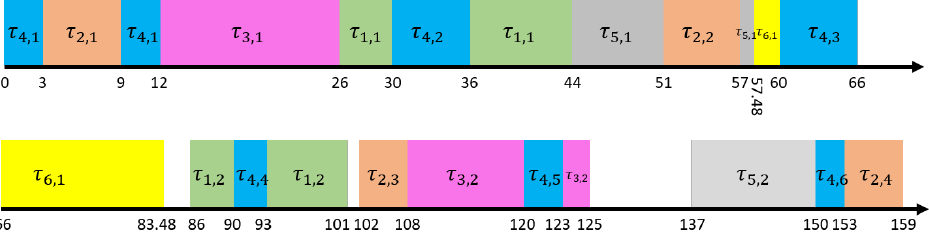
Figure 1. Scheduling result of task set under FMC scheme.